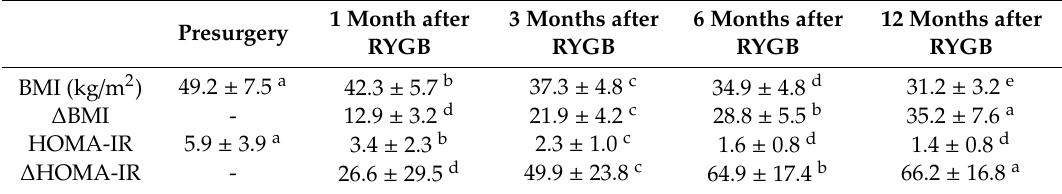
Table 4. Body mass index (BMI), insulin resistance (HOMA-IR) and their changes ( ∆ ) after RYGB. 1 Month after 3 Months after 6 Months Presurgery RYGB RYGB